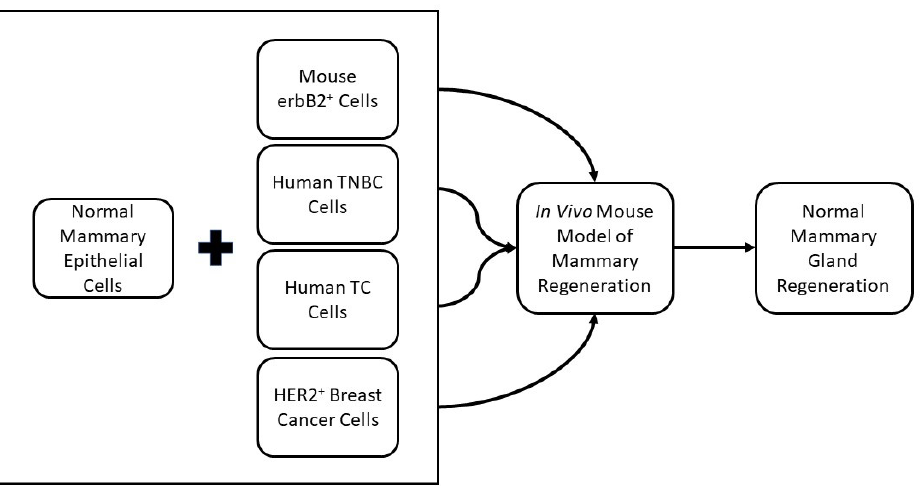
Figure 2. Outline of how multiple studies have demonstrated that the normal mammary microenvironment can redirect cancer cells when placed in the in vivo mouse model of regeneration to participate in normal mammary gland regeneration [15,16,30,31]. TC—Testicular Carcinoma, TNBC—Triple-Negative Breast Cancer.